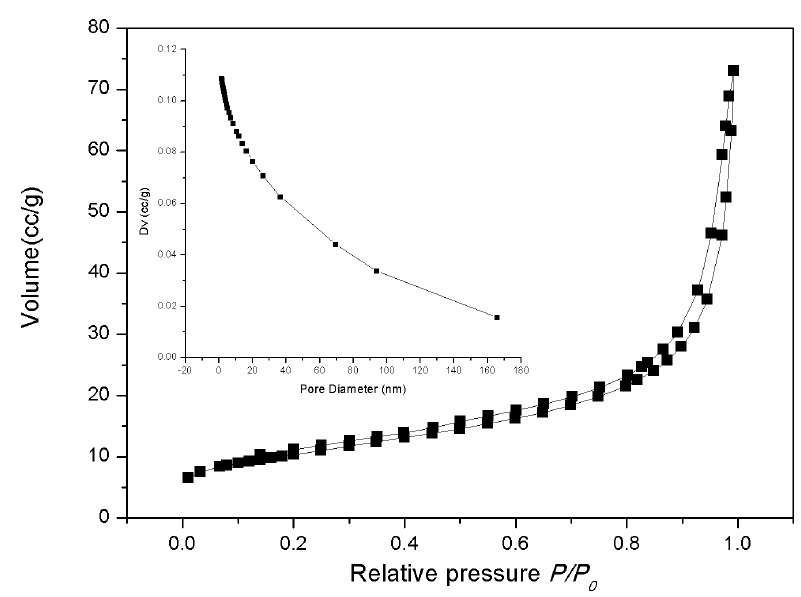
Figure 3. Nitrogen adsorption-desorption isotherm of 3D hierarchical structured CeO 2 . The inset shows the pore size distribution curve obtained from the desorption data.